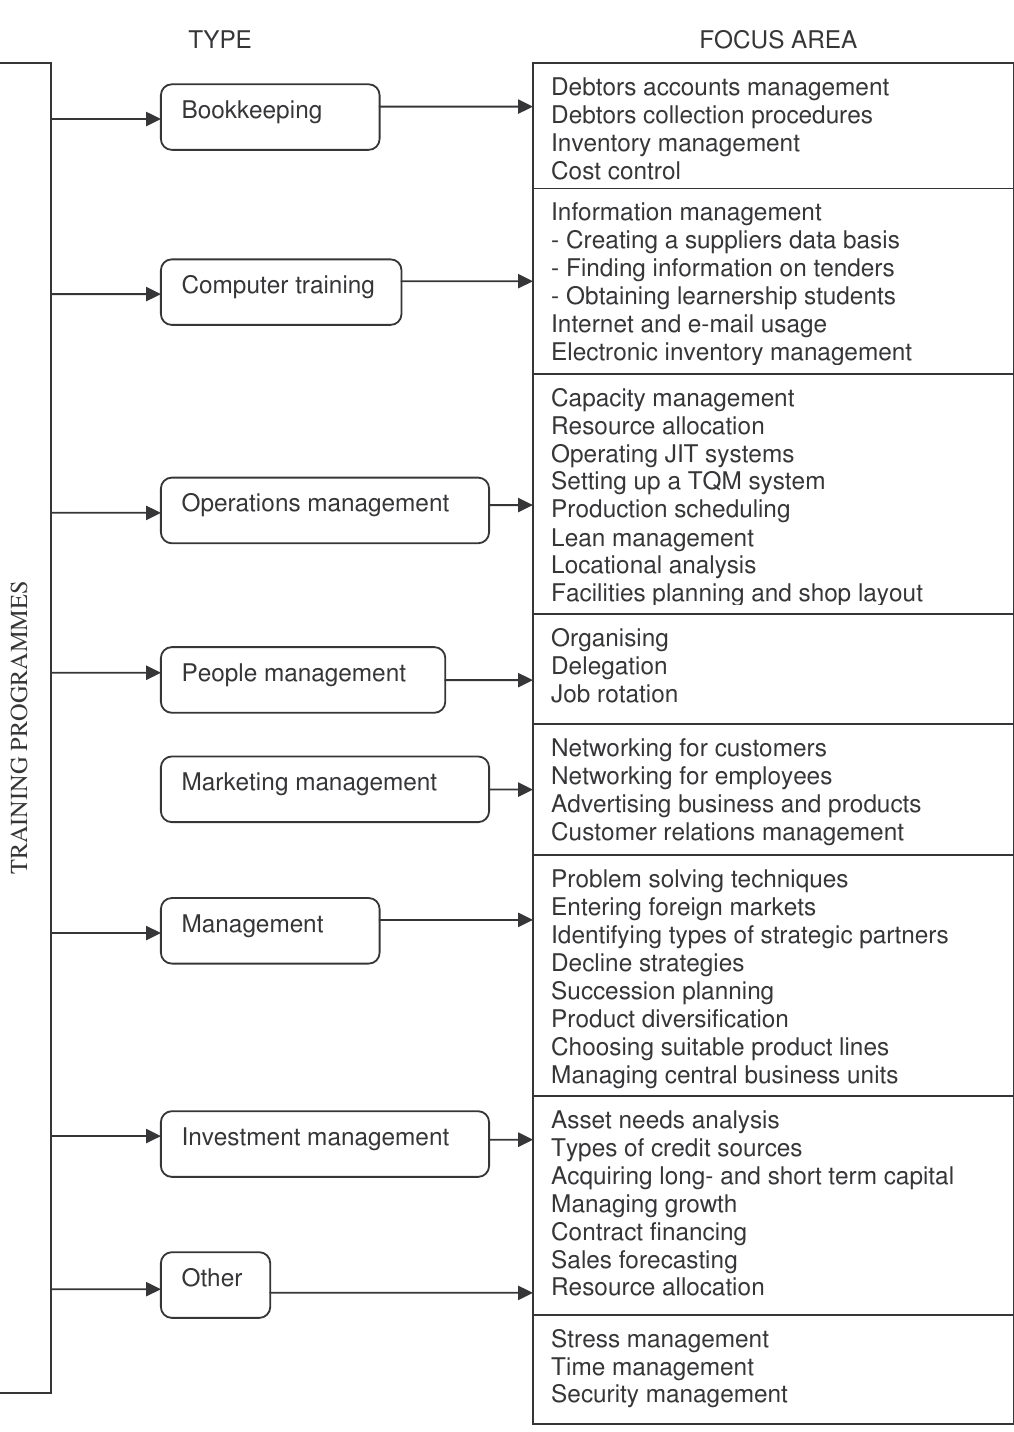
Figure 1:Types of training programmes and focus